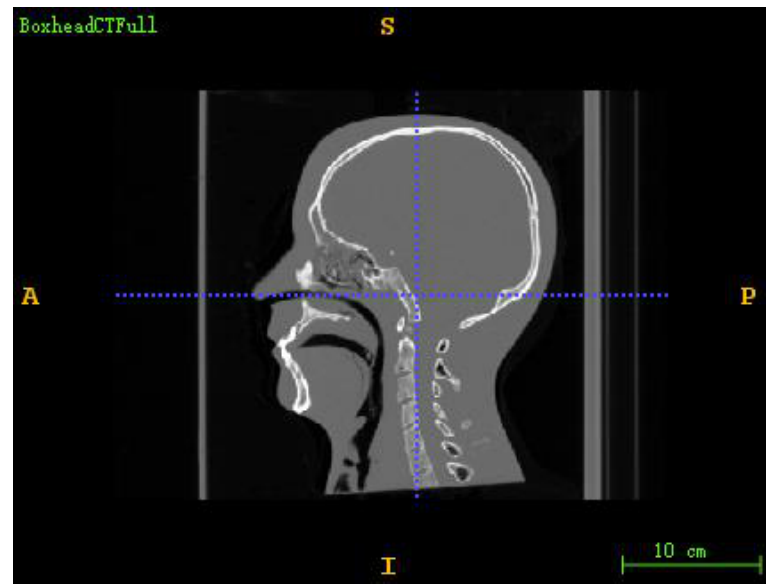
Figure 1. Three dimensional CT of the brain model.